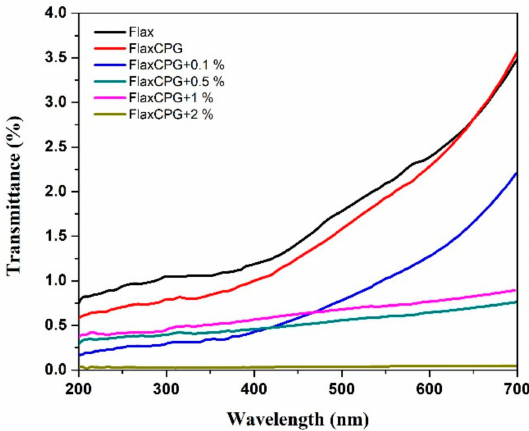
Figure 11. Transmittance spectra of the several samples under